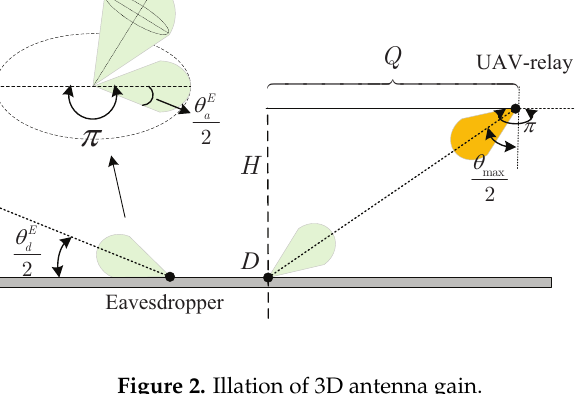
Figure 2. Illation of 3D antenna gain.